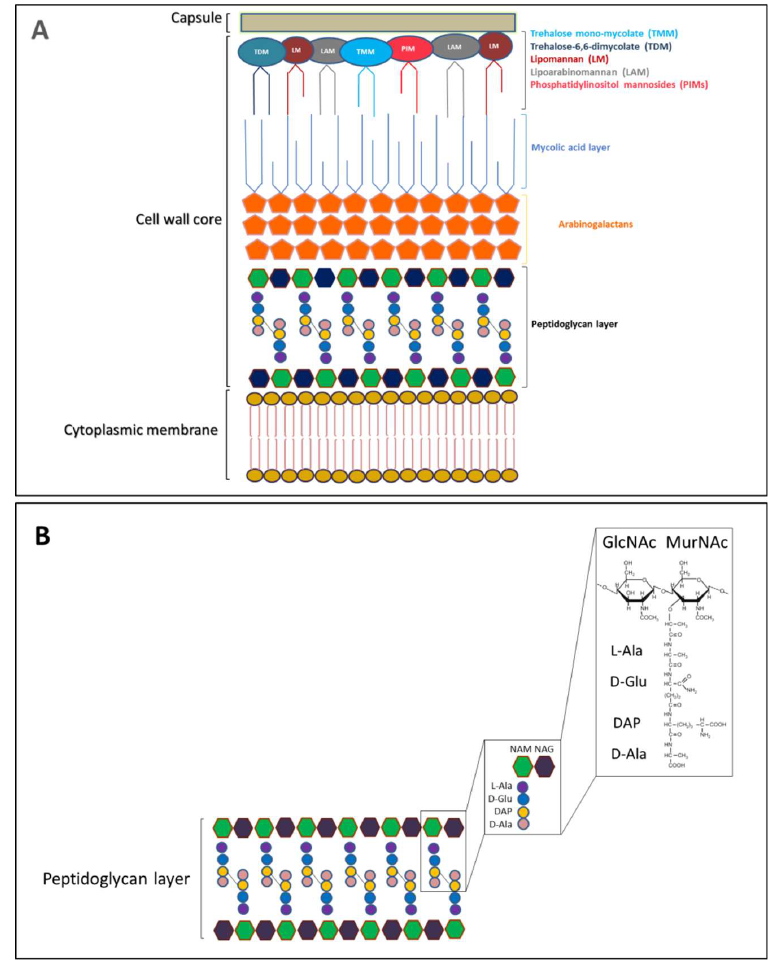
Figure 2. Mycobacterium tuberculosis cell envelope. ( A ) Overall architecture of the cell envelope of Mycobacterium tuberculosis . ( B ) A schematic representation of peptidoglycan (PGN) along with the chemical structure of a PGN monomer.